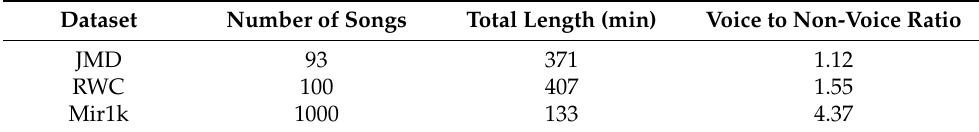
Table 2. Summary of the datasets used for the experiments.